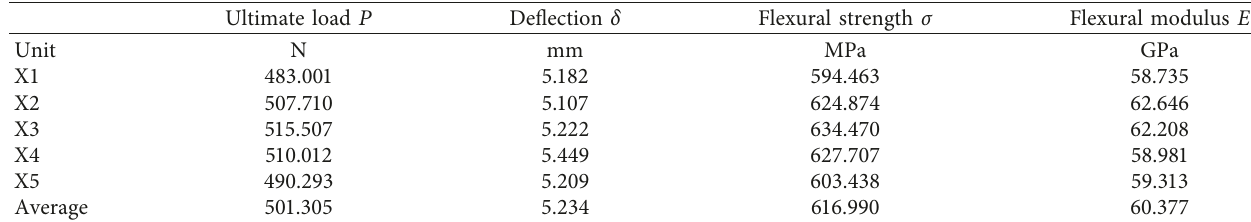
Table 2: Three-point bending test data of carbon fibre/epoxy composites laminate.